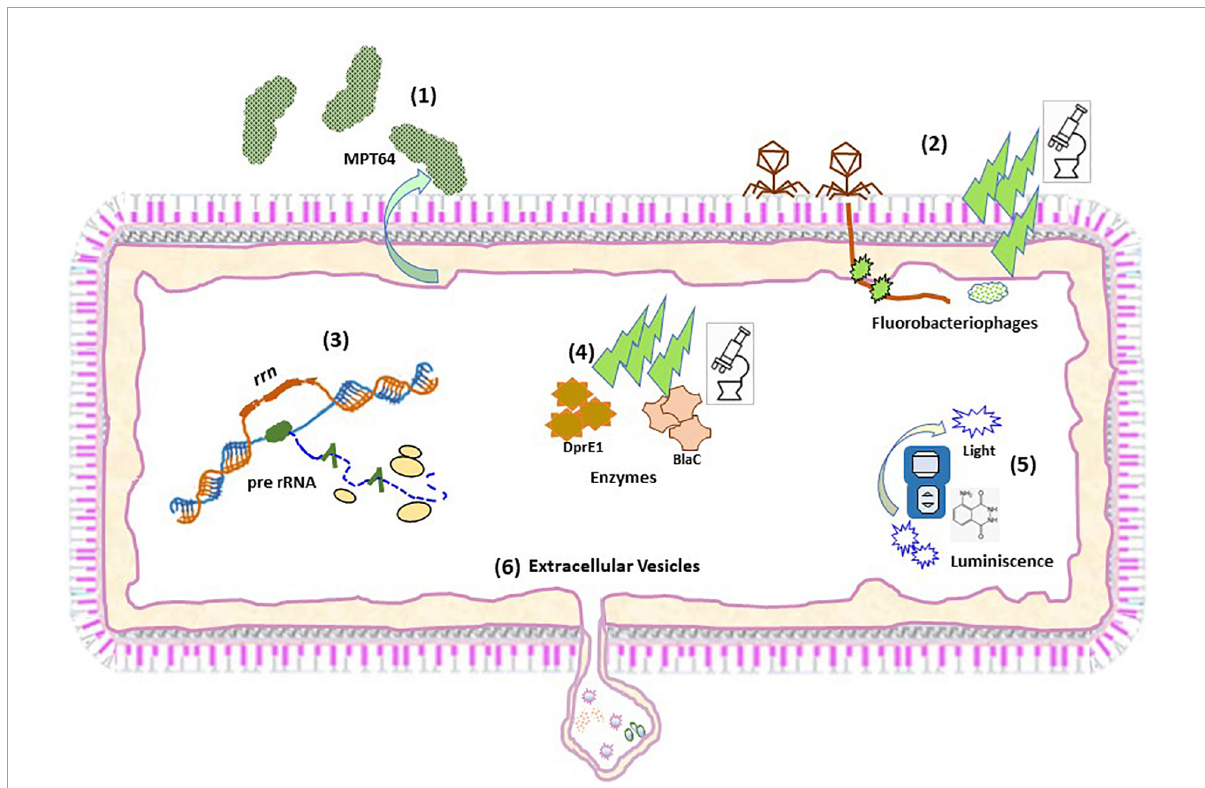
FIGURE1 Schematic representation of the different approaches to detect viable Mtb . Schematic representation of the procedures to detect: MTP64 (1) ; Fluorobacteriophages (2) ; pre-rRNA (3) ; Fluorescent activity probes (4) ; Chemilumiscent probes (5) ; and Extracellular vesicles (6)